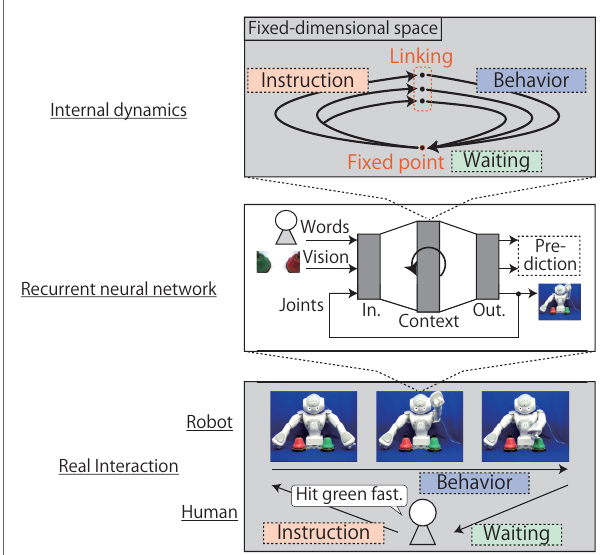
FIGURE 1 | Representation of interactions by the internal dynamics of the RNN context layer . First, in the instruction phase, by receiving words input to the network one by one, the internal states of the context layer are activated in the fixed-dimensional space, branching in accordance with the meaning of the words. After the instruction, the internal states reach a certain activation corresponding to the meaning of the sentence. From the activation (i.e., the linking point), the network immediately generates appropriate behavior in subsequent forward calculation, while the internal states move along the second half of the attractor. Eventually, the internal states return to the initial point, which has been formed as a fixed point, and the robot waits for another instruction in a stable